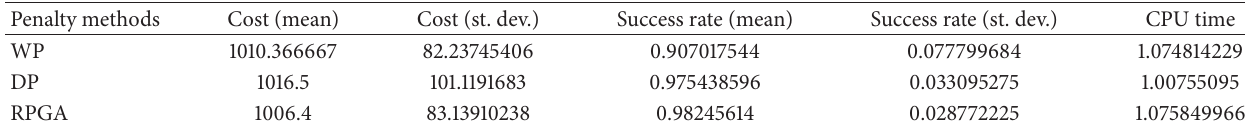
Table 4: The results of different penalty methods.